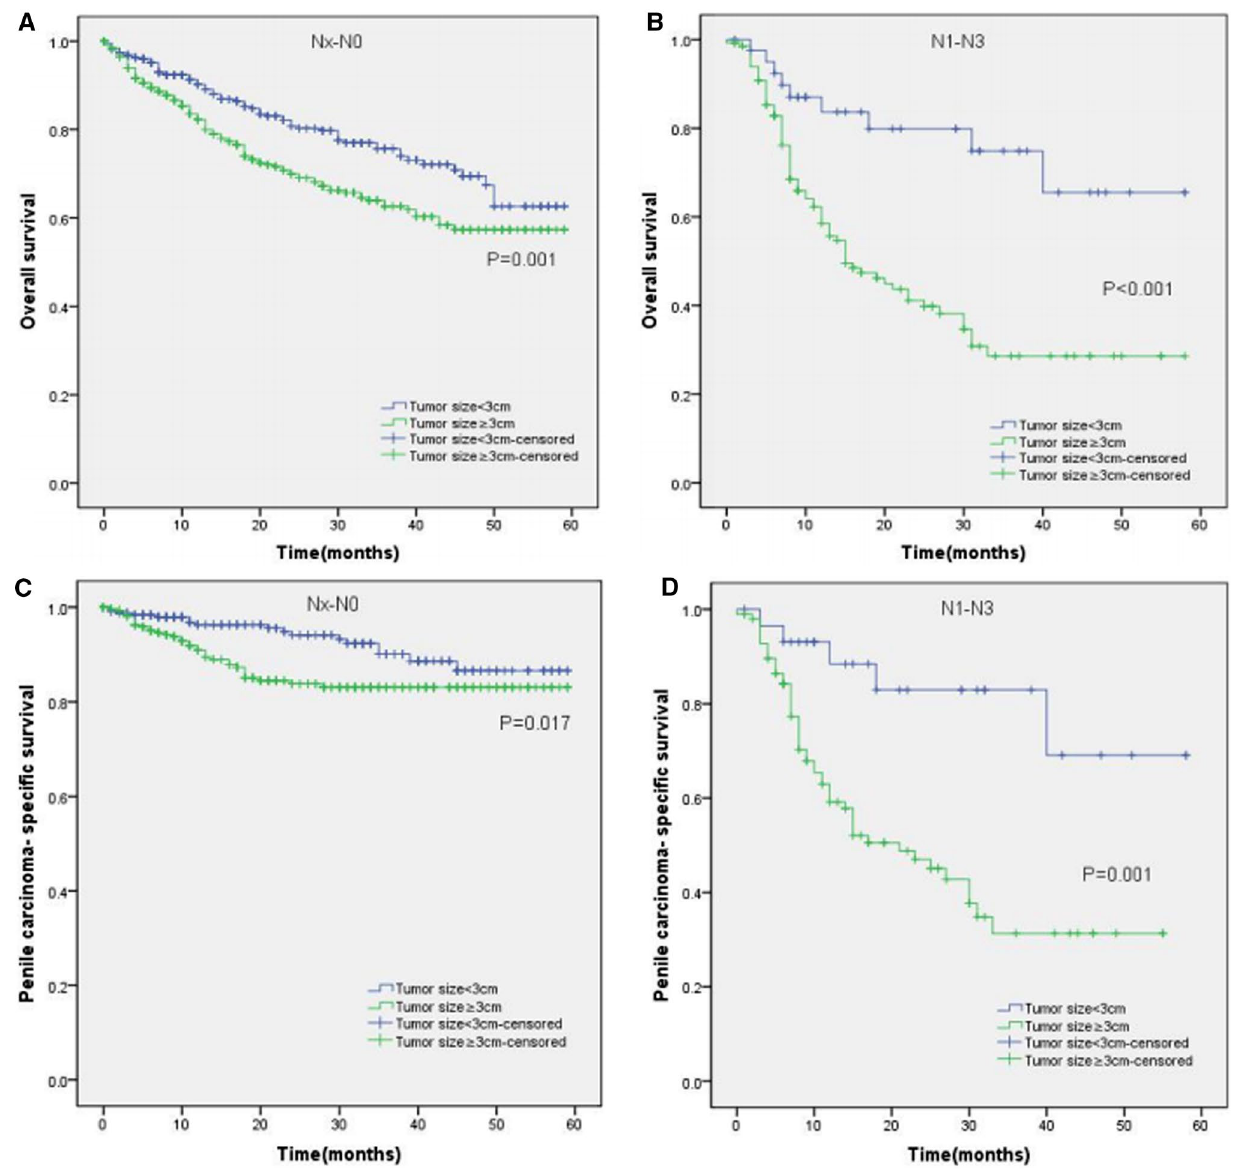
Fig. 5 Kaplan–Meier analyses of overall survival ( A , B ) and penile carcinoma-specific survival ( C , D ) between Nx–N0 group and N1–N3 group in patients stratified by tumor